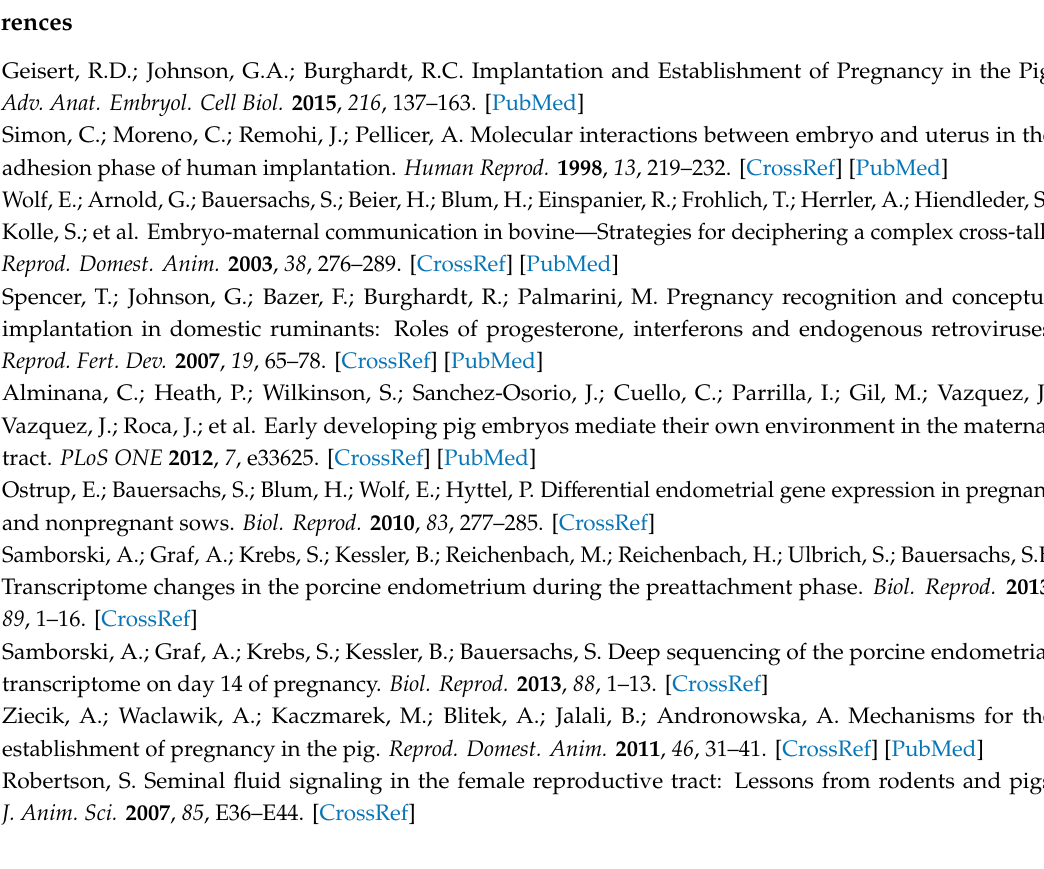
Table S1: Microarray analysis data listing di ff erentially regulated genes that were up- or downregulated on day 6 of pregnancy as compared to day 6 of the estrous cycle, Table S2: Microarray analysis data listing di ff erentially regulated genes that were up- or downregulated on day 6 after seminal plasma infusion as compared to day 6 of the estrous cycle, Table S3: List of 19 common di ff erentially regulated genes between day 6 of pregnancy and day 6 after seminal plasma infusion, Table S4: Disease and function analysis (IPA analysis) of DEGs identified on day 6 of pregnancy as compared to day 6 of the estrous cycle, Table S5: Disease and function analysis (IPA analysis) of DEGs identified on day 6 after seminal plasma infusion as compared to day 6 of the estrous cycle, Table S6: List of upstream regulators that might regulate the expression of DEGs identified on day 6 of pregnancy, Table S7: List of upstream regulators that might regulate the expression of DEGs identified on day 6 after seminal plasma